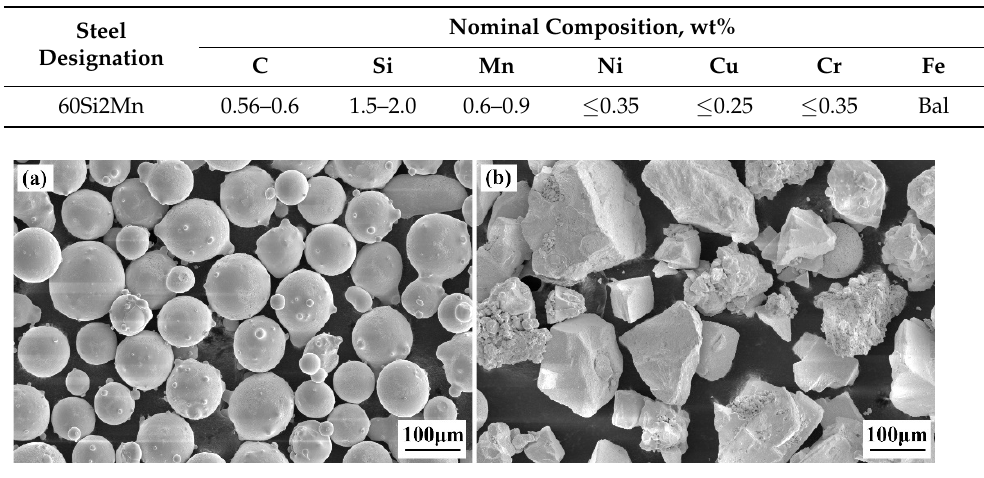
Table 1. Chemical composition (wt%) of 60Si2Mn steel substrate material.